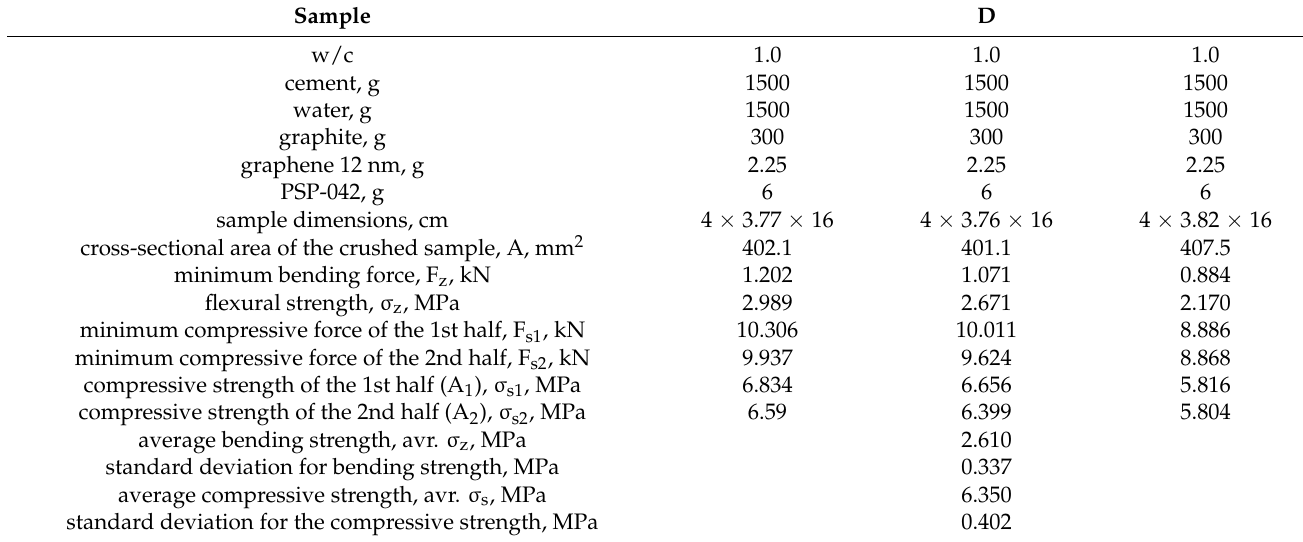
Table 5. Strength test results of the hardened sealing slurries: sample